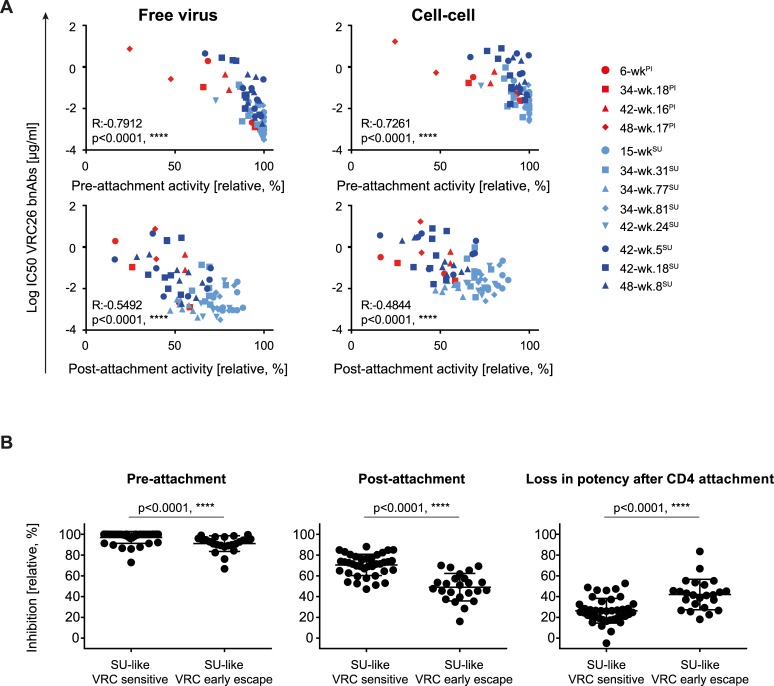
SU-like sensitive and SU-like VRC26 early escape viruses are differently neutralized post CD4 attachment.A: Interdependencies of pre- or post-attachment activity and IC50 for free virus (left) or cell-cell neutralization (right). Spearman correlations on untransformed data sets with R and p values are shown. Neutralization data are derived from data sets depicted in Fig 2, pre- and post- attachment data are derived from data sets depicted in Fig 7. PI-like, SU-like VRC26 sensitive and SU-like VRC26 early escape viruses are marked in red, light blue and dark blue respectively. B: Pre- and post-attachment inhibition and loss in activity after CD4 attachment based on data depicted in Fig 7 were compared for SU-like VRC26 sensitive and SU-like early escape viruses using the Mann-Whitney test. P values are indicated.